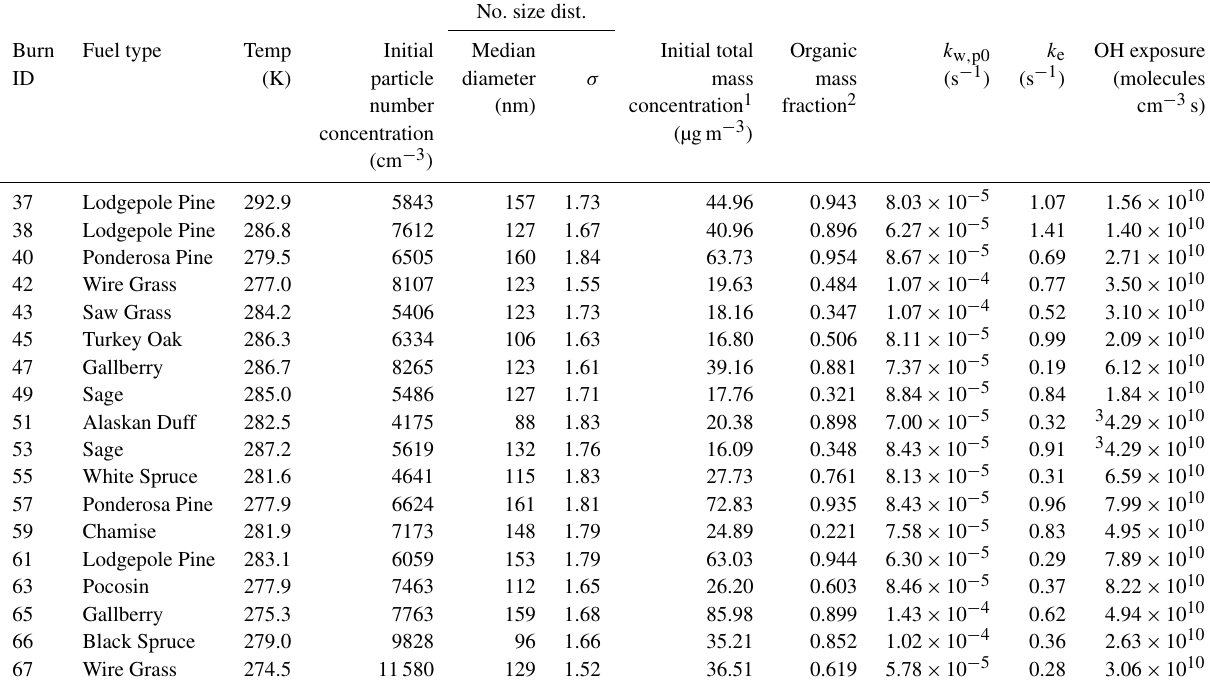
Table 1. Data for 18 wood-smoke samples introduced to the smog chamber, including fuel types, initial number concentration, and corre- sponding size distribution parameters (median diameter in nm and geometric standard deviation, σ) , initial total aerosol nonrefractory mass concentration, the organic mass fraction of the aerosol phase, and OH exposure rate. The Burn ID and OH exposure refer to the schedule of burns in FLAME III, as reported in Hennigan et al.